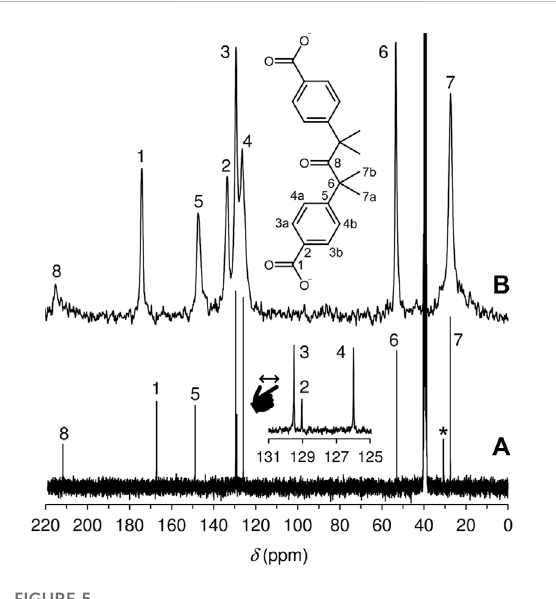
(A) Solution 13 C{ 1 H} NMR spectrum of the ketodiacid 3 in DMSO-d 6 . The resonance labelled with an asterisk is due to residualacetone. (B) 13 C{ 1 H}CPMASNMRspectrumofLDH-KDA3.